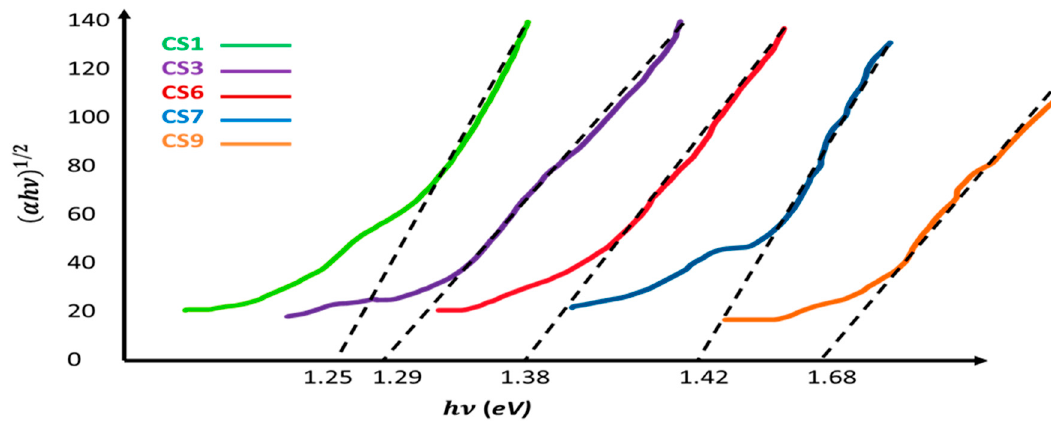
Figure 5. ( α h ν ) 1 2 versus hv . Figure 5. (𝛼ℎ𝜈) 𝟏 𝟐 versus ℎ𝜈 . Table 4. Exprimental parameters.